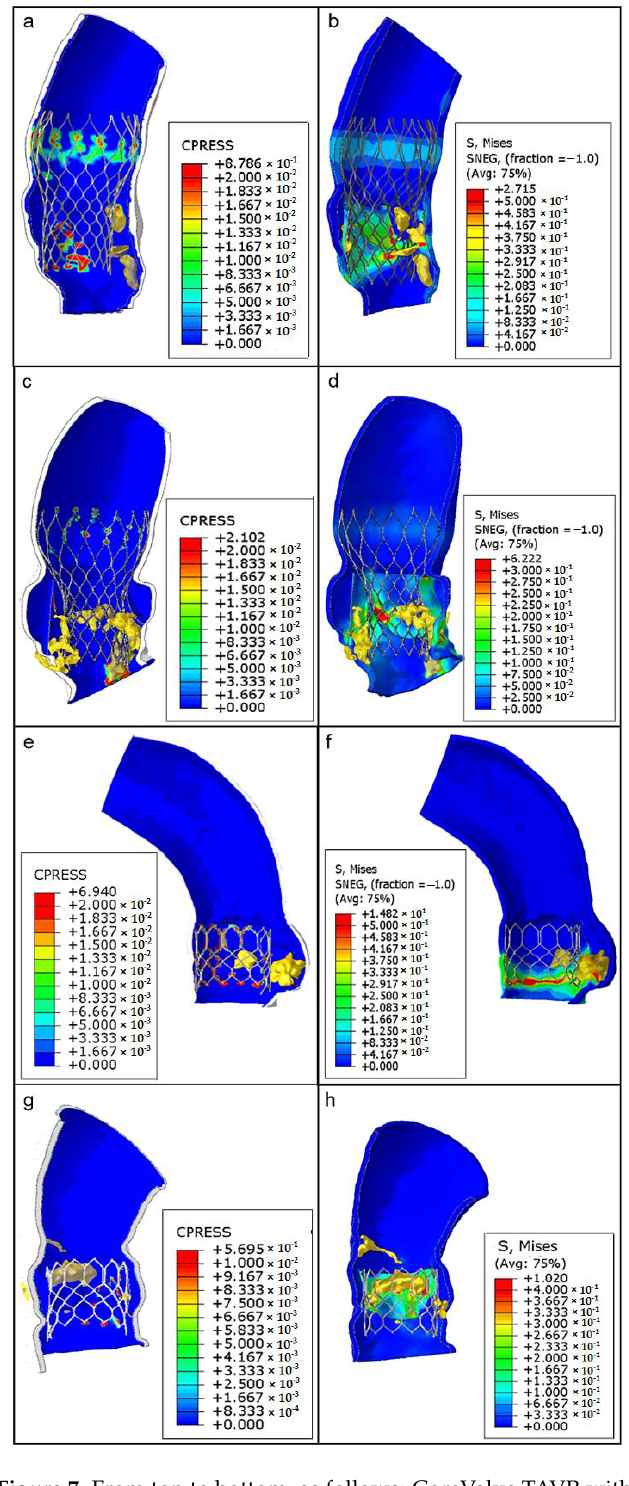
Figure 7. From top to bottom, as follows: CoreValve TAVR with postoperative complications ( a , b ), CoreValve implant as a case control ( c , d ), Sapien TAVR with consequent thrombosis ( e , f ), and Sapien implant without any complications ( g , h ). Contact pressure (CPRESS): measurement of the interaction between the expanded device and the inner aortic surface elements (left panels); von Mises average stress distribution (S, MISES): measure of stress induced by the device expansion onto the aortic wall (to the